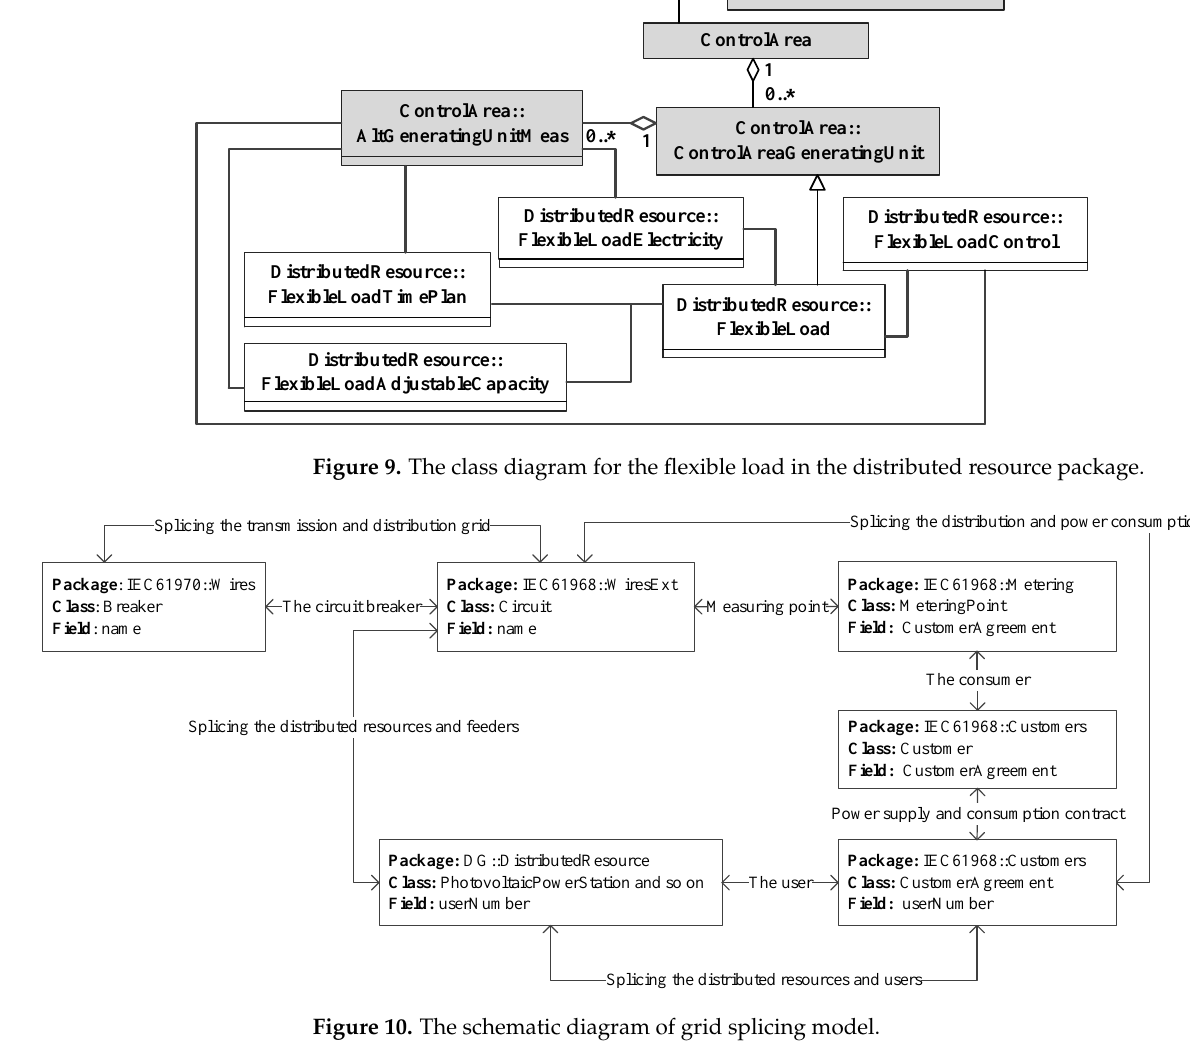
Figure 10. The schematic diagram of grid splicing model.